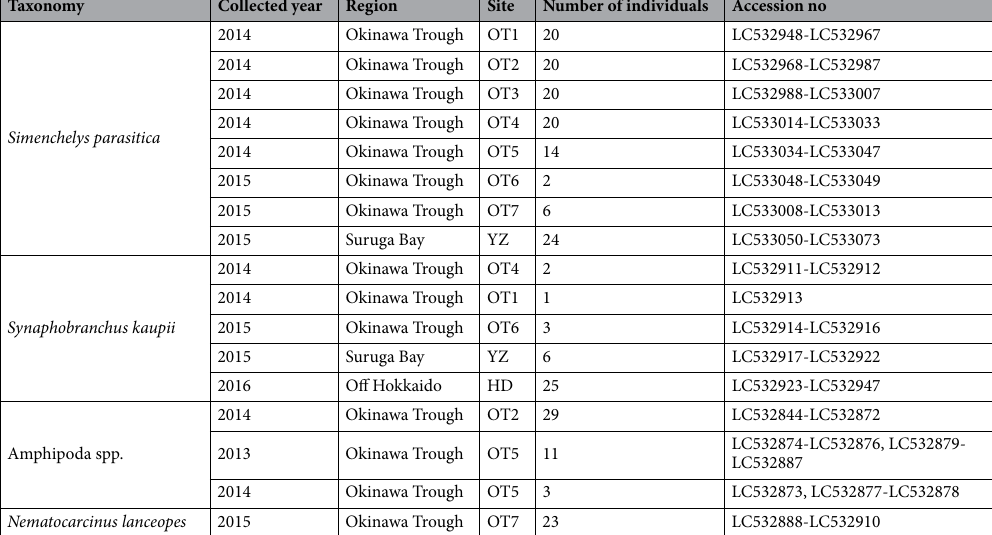
Table 1. Summary of specimens used in this study, the areas where they were collected, and Accession numbers associated to their DNA entries in DNA Data Bank of Japan database. The average distance between the different samples collected in Okinawa (OT) is 3.29 km, and the distance range is 0.02–7.90 km. The average depth for the whole set of samples analyzed in this study (YZ + HD + OT) is 1520 m, and the depth range is 840–1628